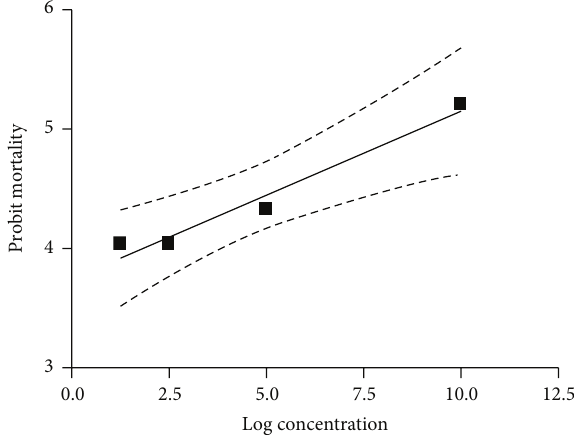
Figure 4: Dose mortality curve of R. (B.) annulatus against petrole- um ether extract of leaves of T. leucostaphylum